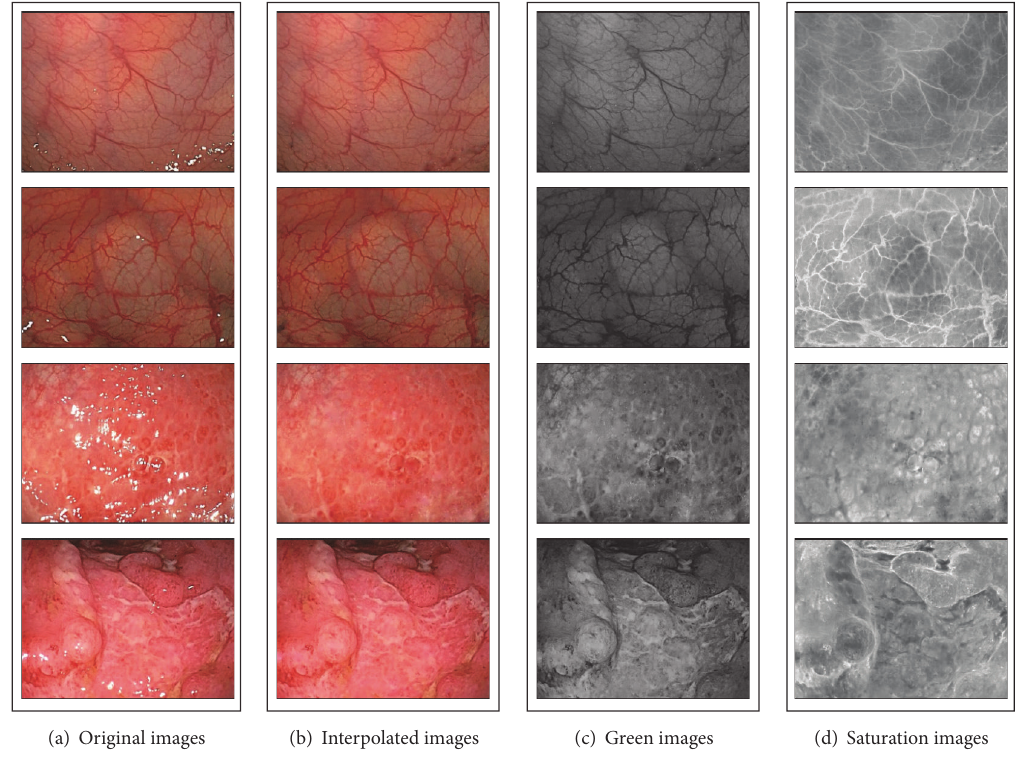
Figure 3: The preprocessed colonoscopy